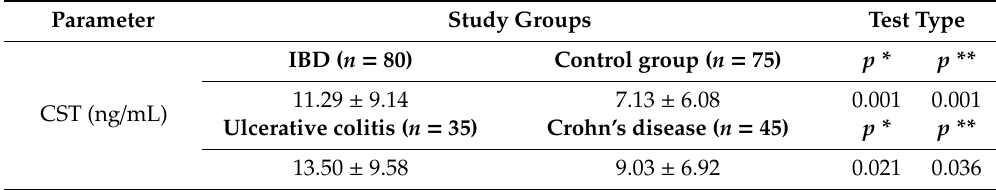
Table 3. Comparison of serum CST concentrations between the study groups.